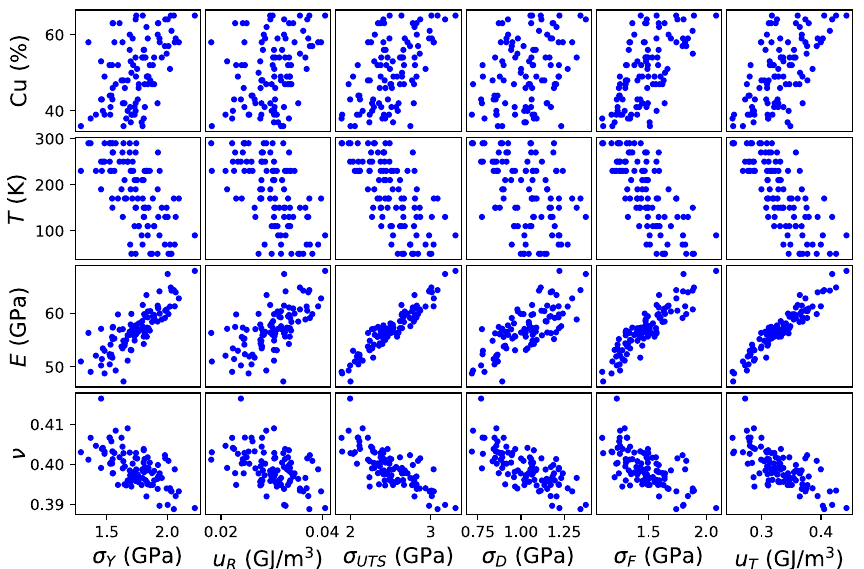
Figure 4. Relationships between materials properties and plastic properties in Cu x Zr 100 − x